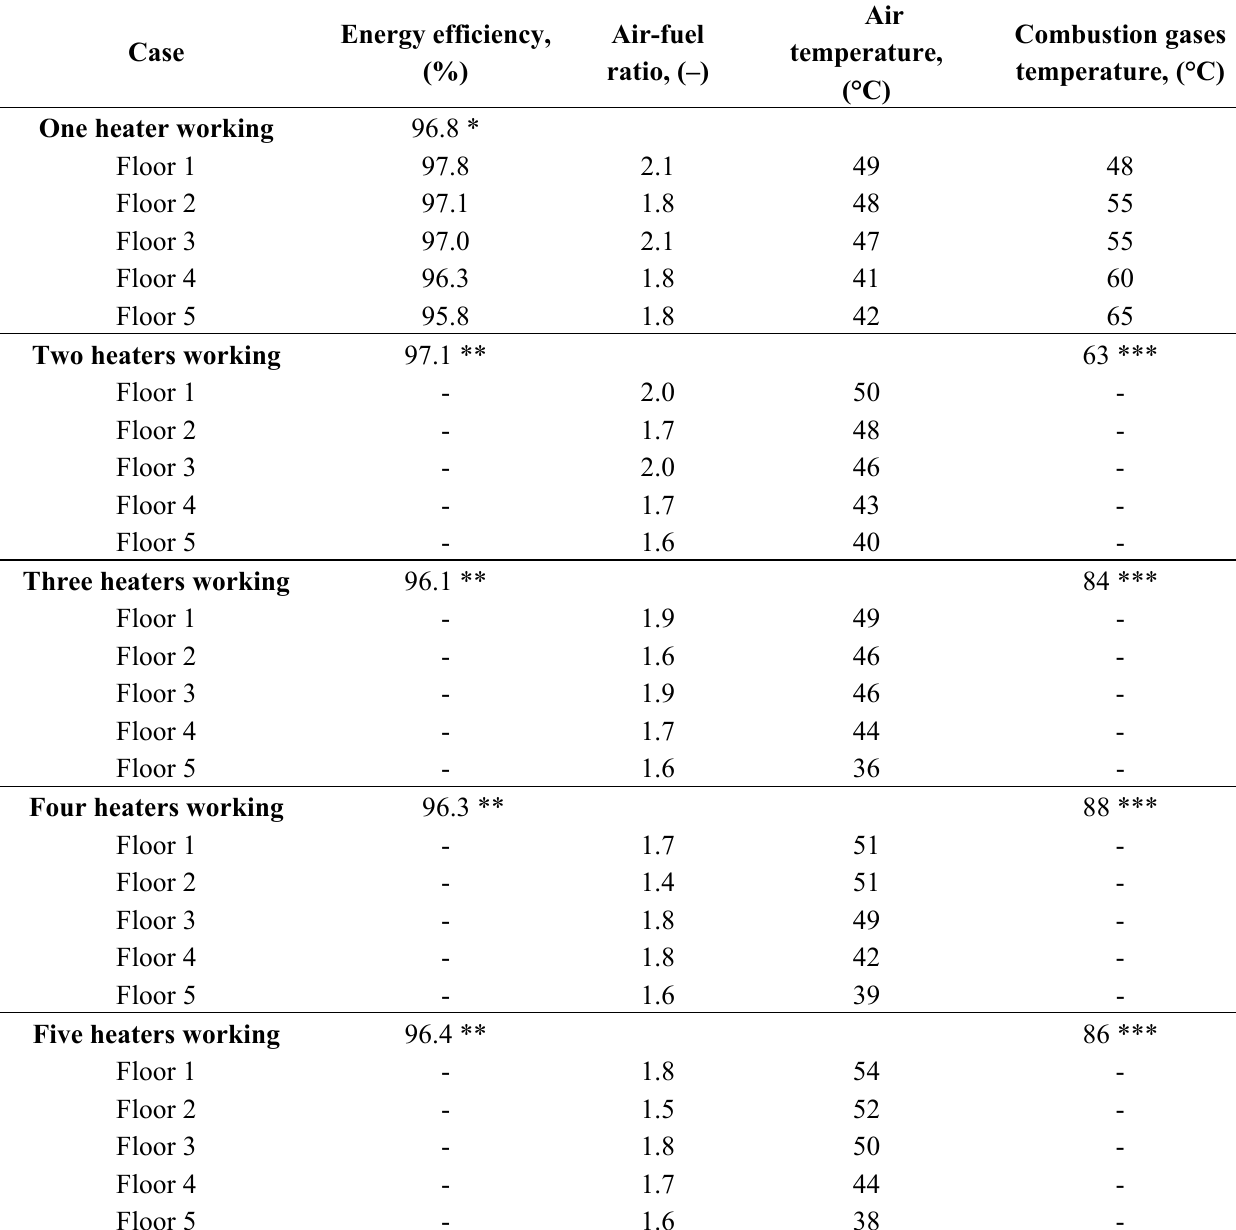
Table 6. Experimental results for the concentric system in multi-story